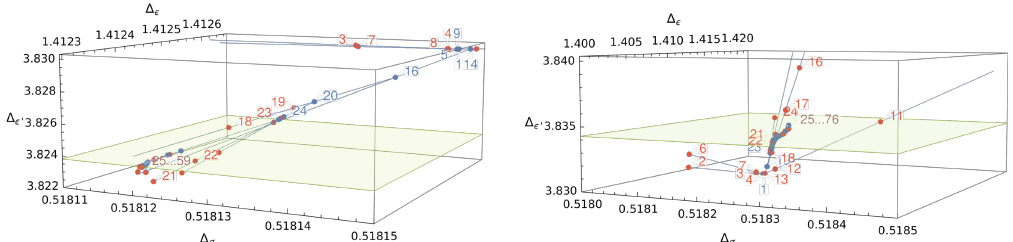
Figure 1 . Example runs of the parameter minimization/maximization algorithm in the 3d Ising island for the N (∆ ∆ ∆ ) navigator (at Λ = 19 ). The search is projected to the 3d subspace (cid:15) , σ , θ, (cid:15) 0 (∆ ∆ ∆ ) . Blue points are allowed points (negative navigator value) and red points are disallowed (cid:15) , σ , (cid:15) 0 (positive navigator value). The green sheet indicates the obtained minimal/maximal values. Left: minimization of ∆ within the Ising island Right: maximization of ∆ (cid:15) 0